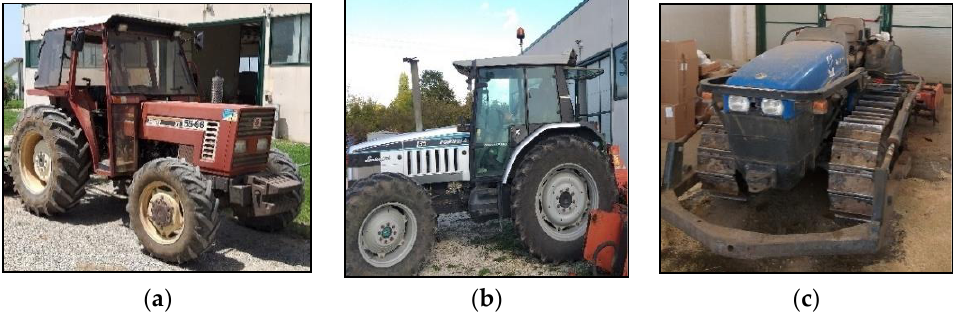
Figure 1. Fiat 55l ( a ), Lamborghini 135 ( b ), and New Holland TLK75FA 2005 ( c ). The measurements were obtained on two-wheeled tractors, and one tracked. The technical characteristics of each vehicle are shown in Table 1. Table 1. Technical characteristic of the tractors. Tractor Mass (kg) Motor Torque (Nm) Engine Power (kW)